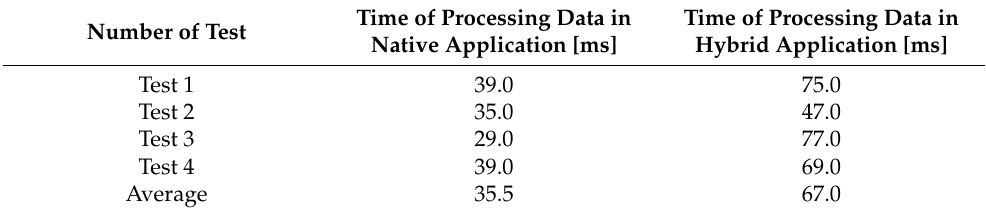
Table 4. Time taken to process the data from REST API (response with 10 objects). Number of Test